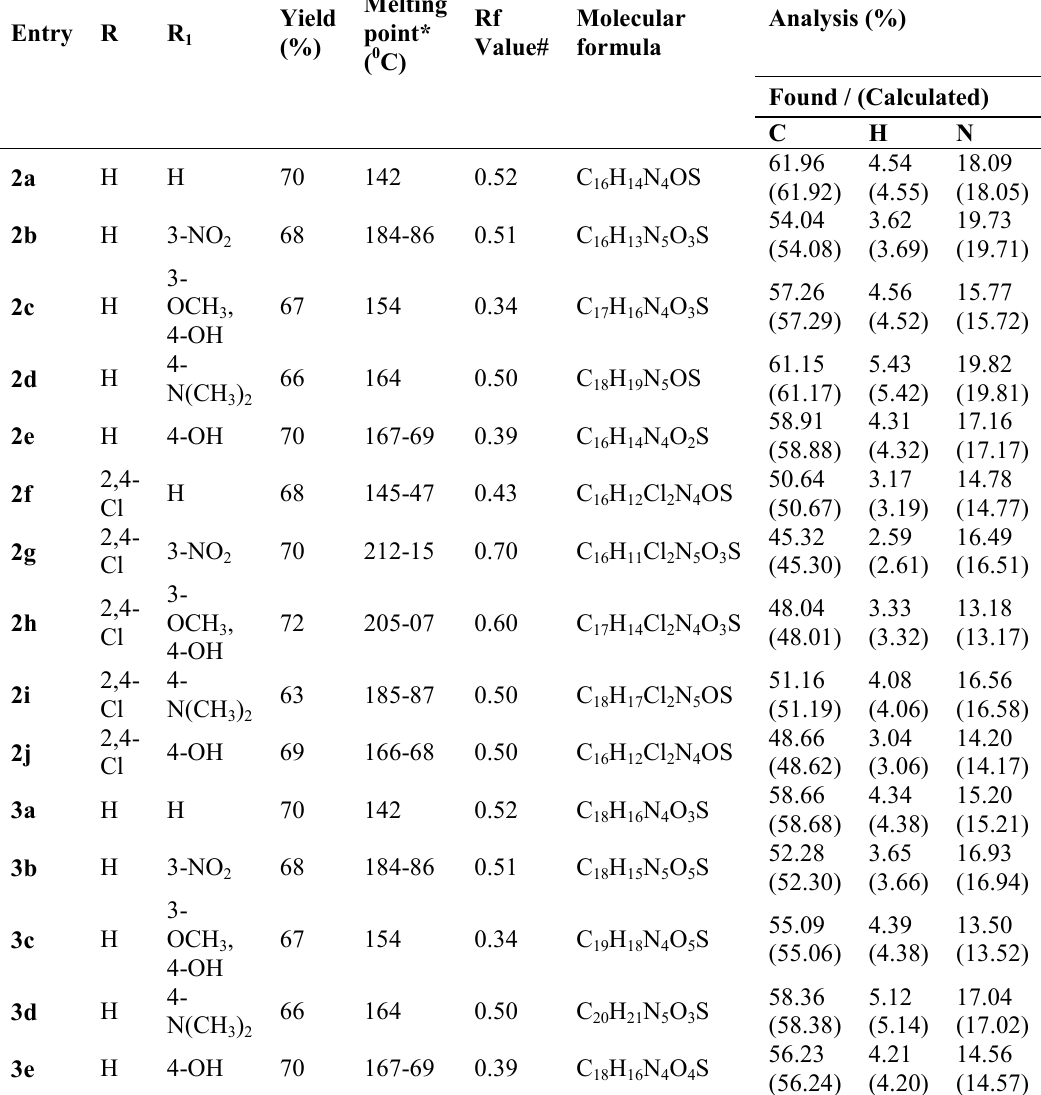
Table 2 . Physical and analytical data of compounds (2a-j) and (3a-j)